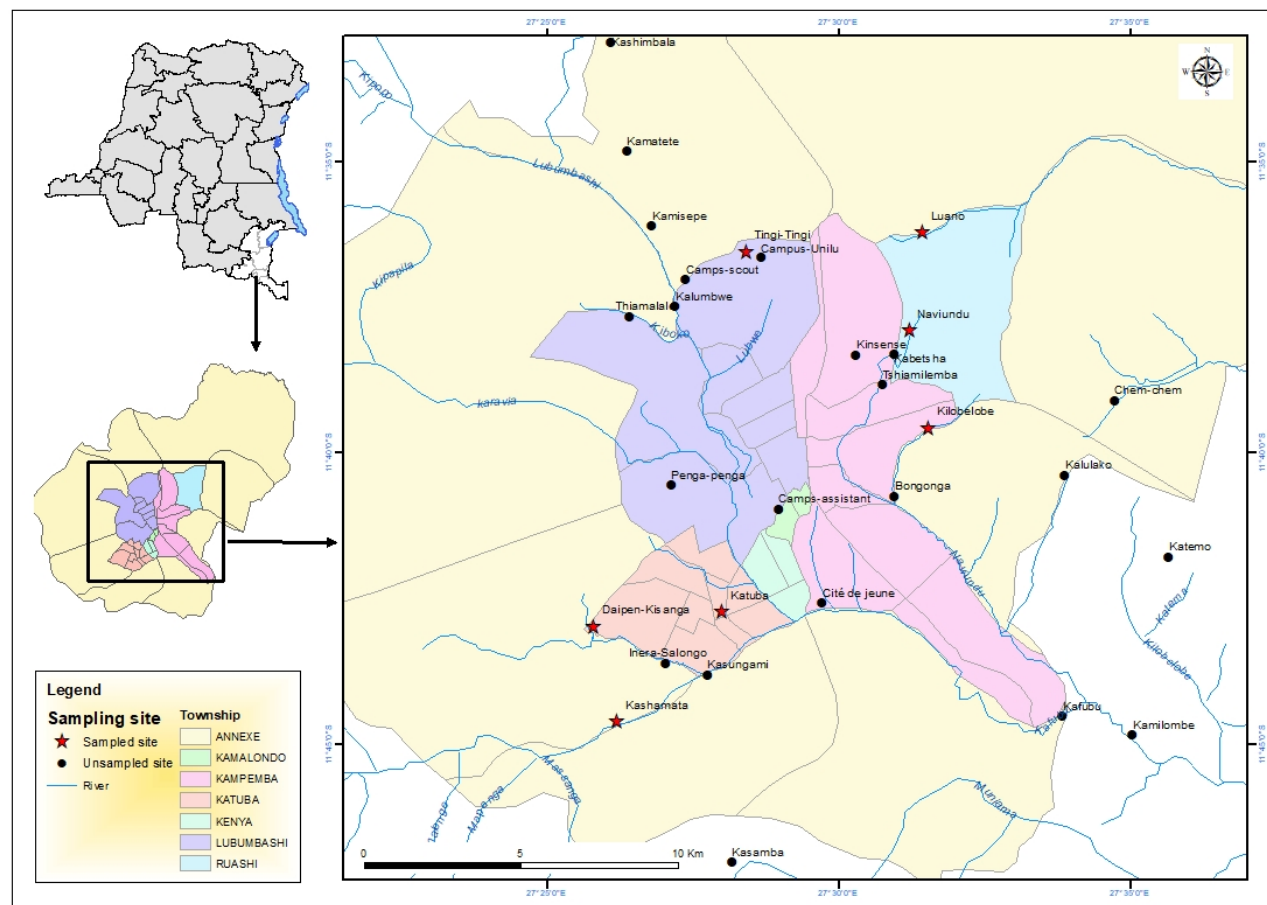
Figure 2. Location of urban agriculture sites in Lubumbashi. Table 2. Distribution of producers according to the sites selected for the study. Names of Selected